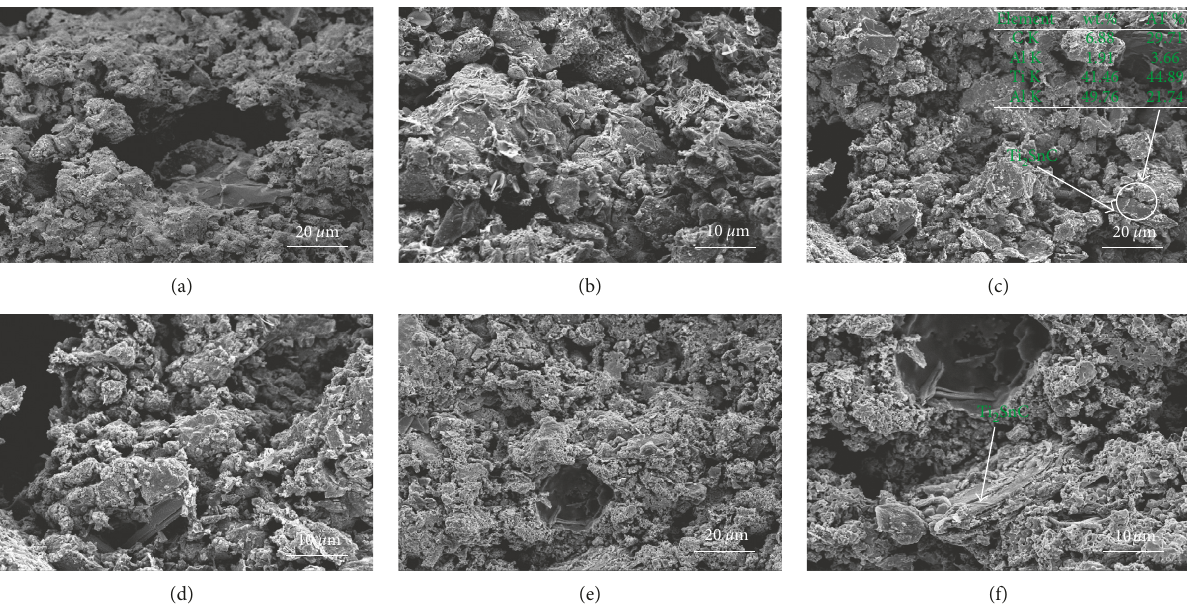
Figure 9: SEM and EDS micrographs of Ti 2 SnC with ratio Ti:Sn:Al:C (cid:31) 2:1:0.2:1 at (a and b) 800